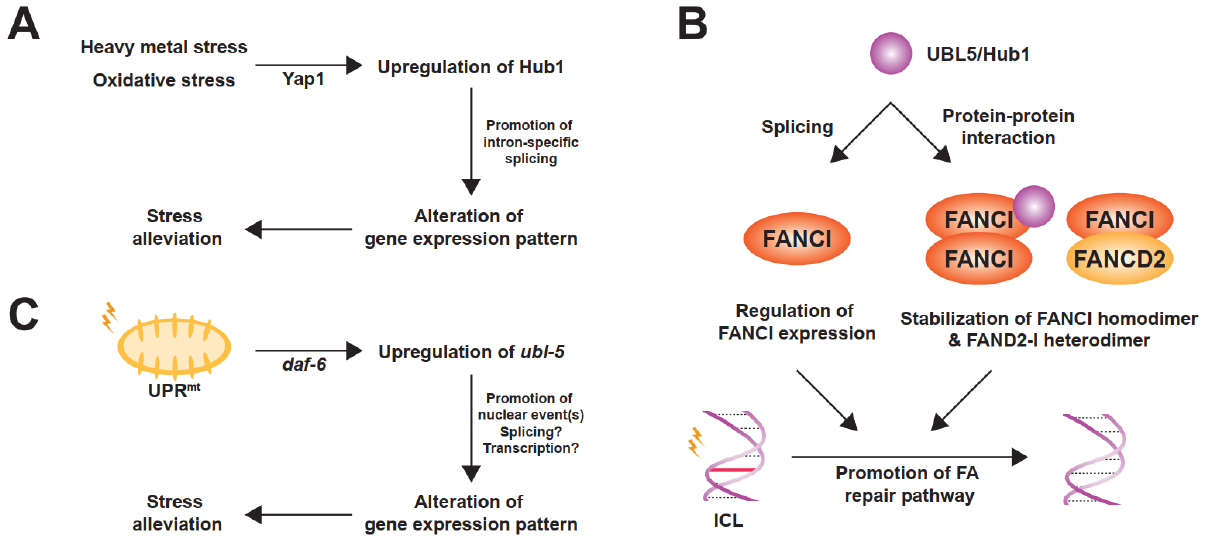
Figure 3. Stress-responsive roles of UBL5/Hub1. ( A ) In S. cerevisiae , Hub1 is upregulated at the transcriptional level upon heavy metal and oxidative stresses by the yeast-AP1 (YAP1) transcription factor. Overexpressed Hub1 facilitates intron-specific splicing and, as a result, contributes to stress tolerance. ( B ) As a splicing regulator, UBL5/Hub1 promotes proper splicing of FANCI pre-mRNA. Additionally, this ubiquitin relative interacts with FANCI protein and helps stabilize FANCI homodimer as well as FANCD2-I heterodimer, thereby facilitating the Fanconi anemia (FA) DNA damage repair pathway to resolve interstrand DNA crosslink (ICL). ( C ) In C. elegans , mitochondrial unfolded protein response (UPR mt ) induces upregulation of ubl-5 which is mediated by the transcription factor daf-16 . The gene product is then accumulated and functions in the nucleus, though precise molecular function to alleviate the mitochondrial stress is unclear.